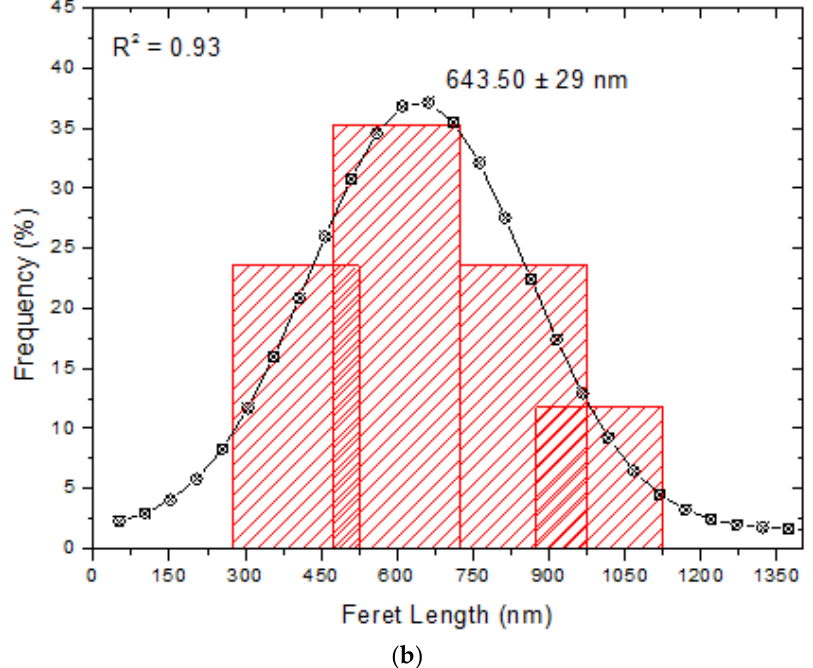
Figure 5. Analysis of the NC/HA/β-TCP surface and quantitative particle size. ( a ) SEM micrographs showing prismatic nanocellulose nucleating agent to obtain HA/TCP; ( b ) histogram relating to frequency and particle size.